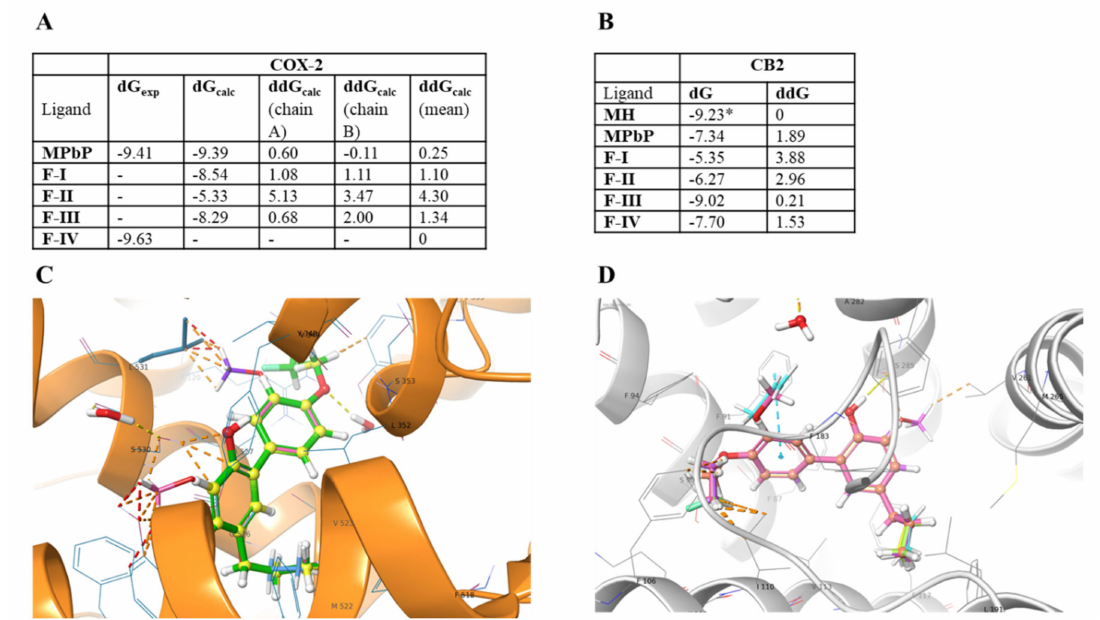
Figure 4. ( A , B ) panels—Computed relative binding free energies of F-I – F-IV to COX-2 (relative free energies (kcal/mol) are given in relation to F-IV ) and to CB-2 (relative free energies are given in relation to MH, * from [26]), respectively. ( C ). Tested compounds aligned to F-IV by their maximum substructure at COX-2 binding site (MPbP—yellow, ball-and-stick; F-I —faded azure, thin tube; F-II —faded salmon, thin tube; F-III —violet, thin tube; F-IV —green, thick tube). ( D ). MH and tested compounds aligned to MH by their maximum substructure at CB-2 binding site (MH—cyan, thin tube; MPbP— faded red-orange, ball-and-stick; F-I —yellow, thin tube; F-II —magenta, thin tube; F-III —faded yellow-green, thick tube; F-IV —azure, thick